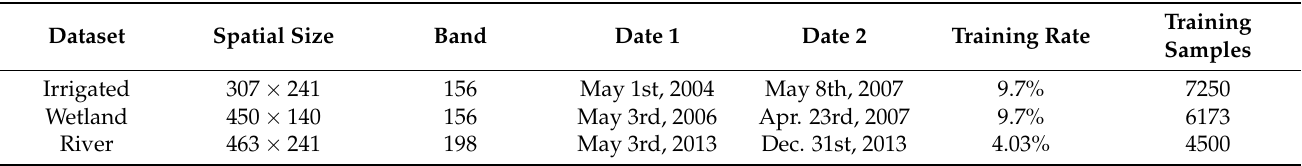
Table 1. Details of the selected